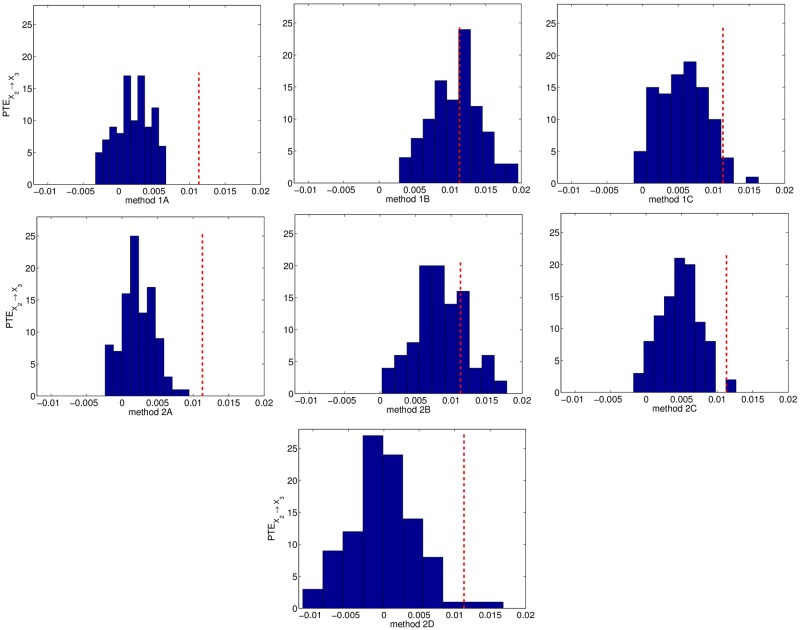
As Fig 2 but for the direction X2 → X3.